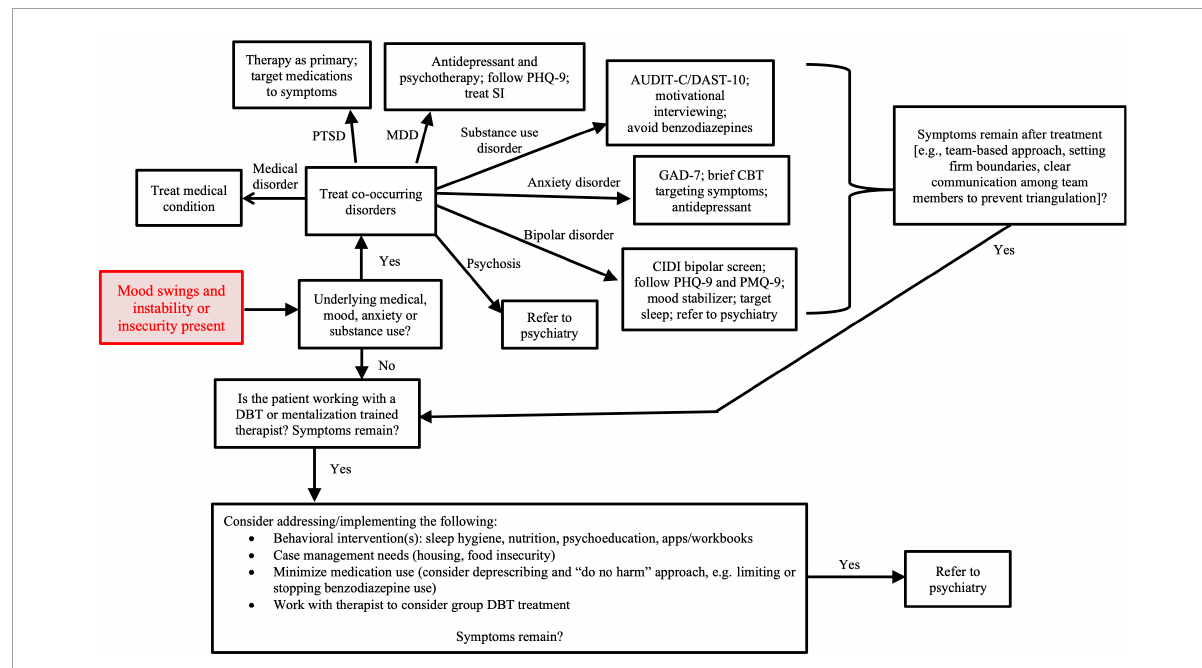
FIGURE1 Treatment approach to mood instability in primary care. AUDIT-C, alcohol use disorder identification test-concise; CBT, cognitive behavioral therapy; CIDI, composite international diagnostic interview; DAST-10, drug abuse screening test; DBT, dialectical behavior therapy;